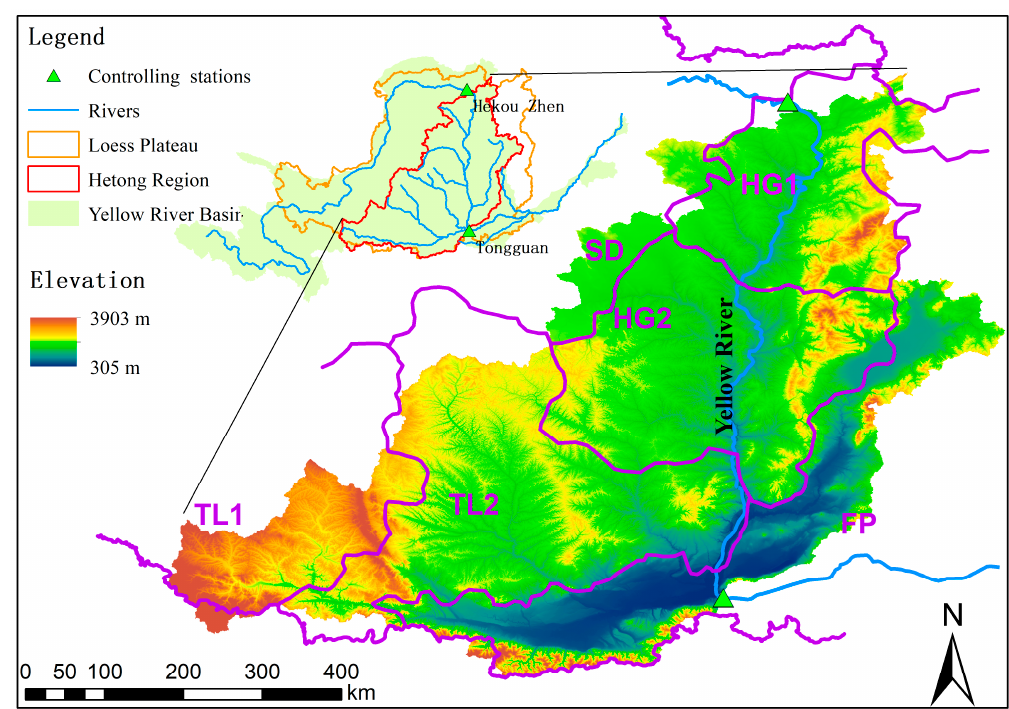
Figure 1. Location of the Hetong region on the Chinese Loess Plateau.